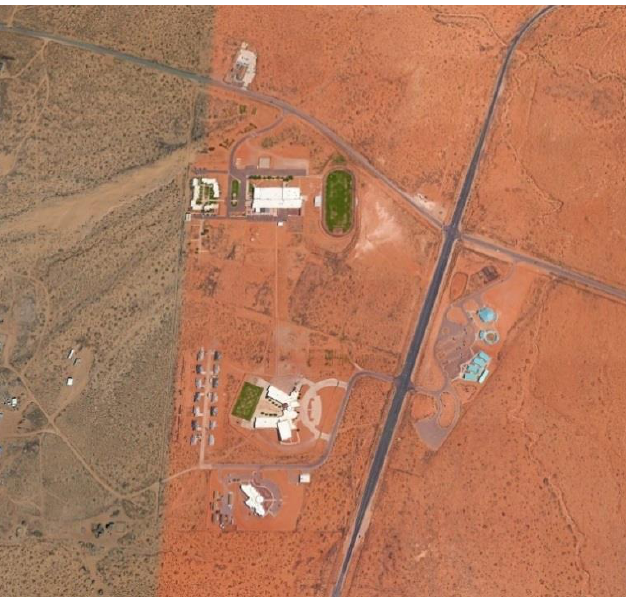
Figure 11. Monument Valley Navajo Tribal Park: athletics and football fields near the visitor centre (from Google Earth Pro V 7.3.4, (19 March 2016), 37°00′09.10″N, 110°10′40.26″W, Eye alt 4.07 km, Landsat, Copernicus, Maxar Technologies/USDA/FPAC/GEO, [46]). The campgrounds, on the other hand, represent a way of experiencing the park closer to its essence, but of course, can be uncomfortable and therefore not usable by the elderly and people with disabilities.